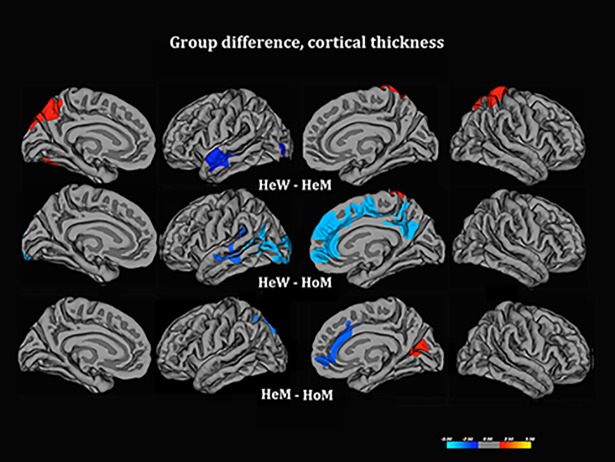
Group comparisons for Cth.The contrasts were calculated at p < .05, corrected for multiple comparisons (Monte Carlo permutation), using age as the covariate of no interest. The projection of cerebral hemispheres (MR images of the FreeSurfer atlas) is standardized. Scale is logarithmic and shows–log10(P), with cool colors indicating negative contrast, warm colors positive contrast. The two smaller images at the bottom illustrate Cth in HeM-HoM (left) and HeW–HoM (right) calculated without Monte Carlo correction; they were added to illustrate the HoM differed from both control groups in a similar manner.